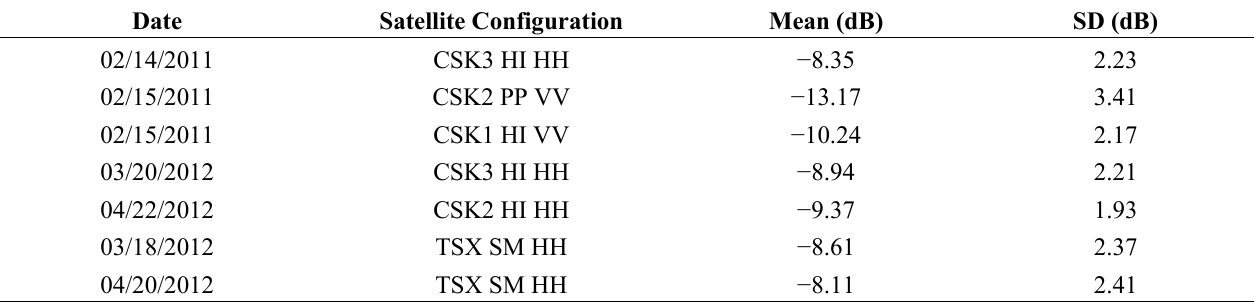
Table 2. Mean and SD of backscattering values collected from CSK and TSX in different configurations over a forest plot in Sesto